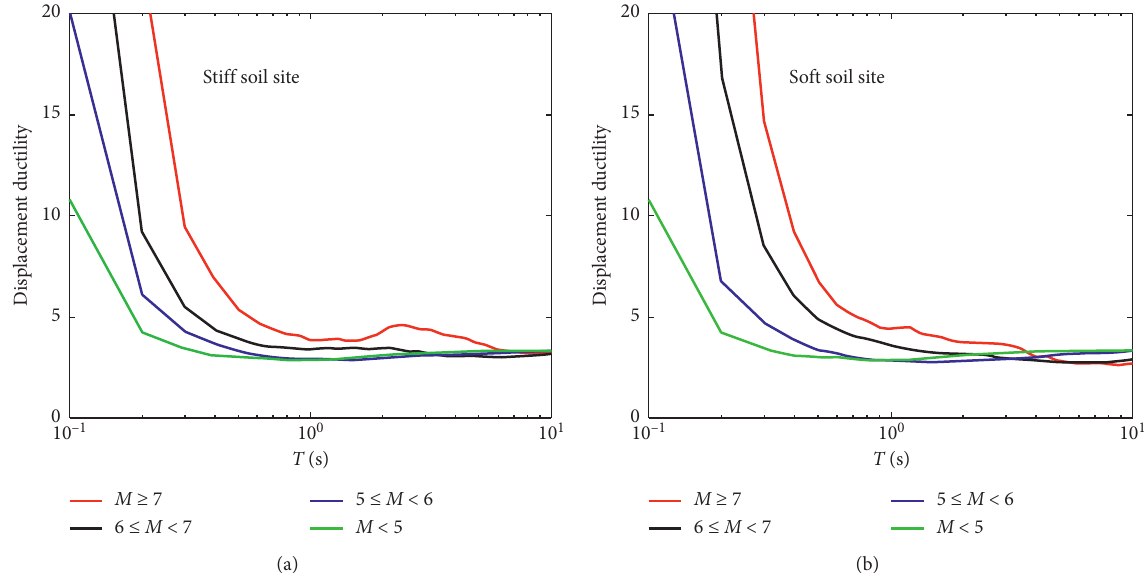
Figure 9: Effect of earthquake magnitude on the variation of mean constant-strength ductility spectra: (a) stiff soil site; (b) soft soil site.